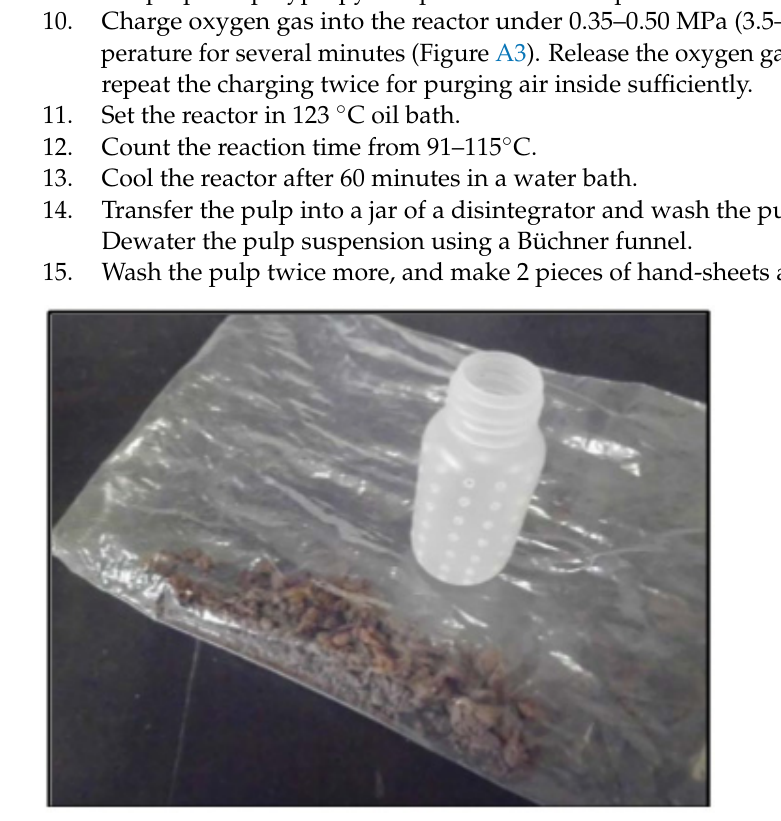
Figure A1. Put pulp in polyethylene plastic bag and make pulp into small particles (diameter 5–10 mm).